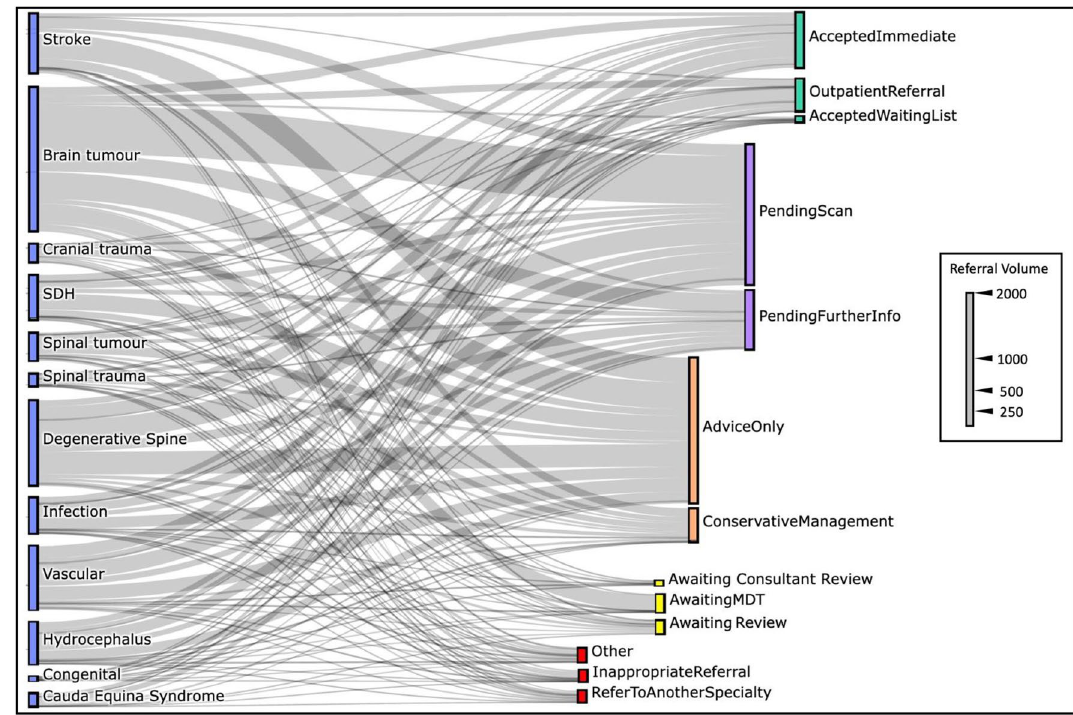
Figure 4. Referral triage decisions. A Sankey plot illustrating decisions made by the on-call registrar/resident sorted by diagnostic classification (blue bars). Triage decisions are grouped according to whether the patient was accepted (green bars), further information was requested (purple bars), advice or conservative management was suggested (orange bars), an additional neurosurgical review was needed to make a decision (yellow bars) or whether the referral was rejected (red bars) ( MDT multidisciplinary team meeting).